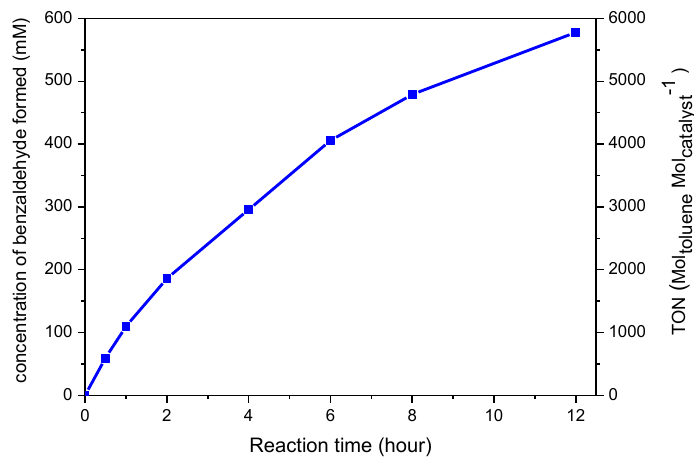
Figure 3. Reaction progress for the oxidation of neat toluene with 0.1 mM of complex 4 as catalyst at a reaction temperature of 100 °C.